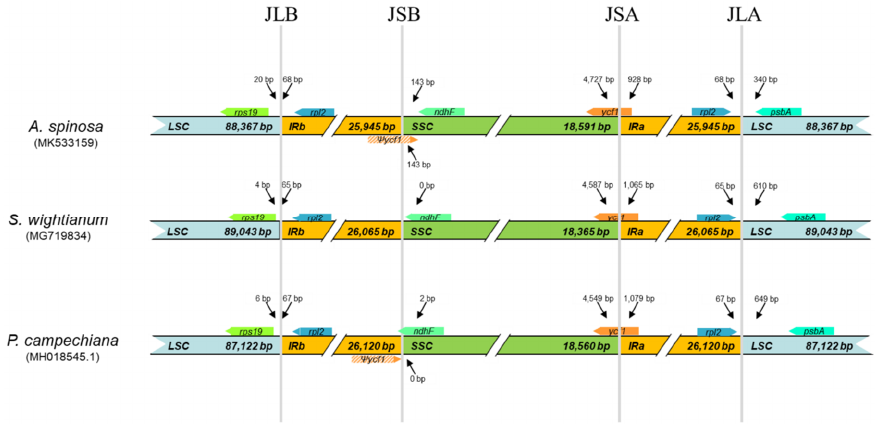
Figure 4. A comparison of the distance between adjacent genes and junctions in the SSC, LSC, and two IR regions for the chloroplast genomes of A. spinosa , Sideroxylon wightianum , and Pouteria campechiana . The figure shows relative changes at or near the IR/SC borders, with no scale to sequence length. The colored boxes indicate genes.